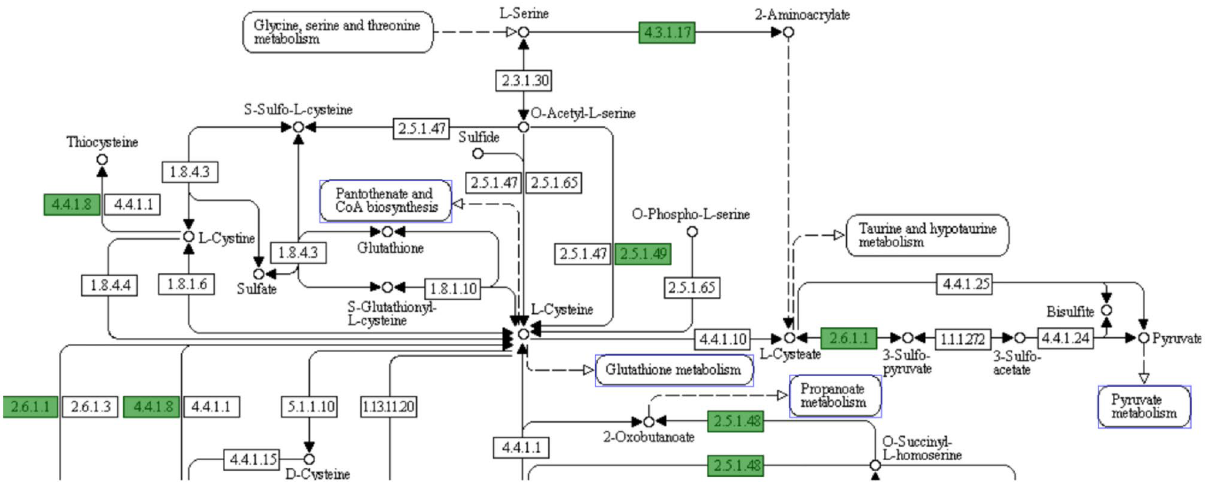
Figure 1. KEGG pathway of l-cysteine of C. hepaticus . Green boxes indicate the genes identified in C. hepaticus while white boxes show absent genes. C. hepaticus lacks genes including cysE (EC 2.3.1.30, serine acetyltransferase), cysK (EC 2.5.1.47, cysteine synthase A), cysM (EC 2.5.1.65, O -phosphoserine sulfhydrylase) and cys3 (EC 4.4.1.1, cystathionine